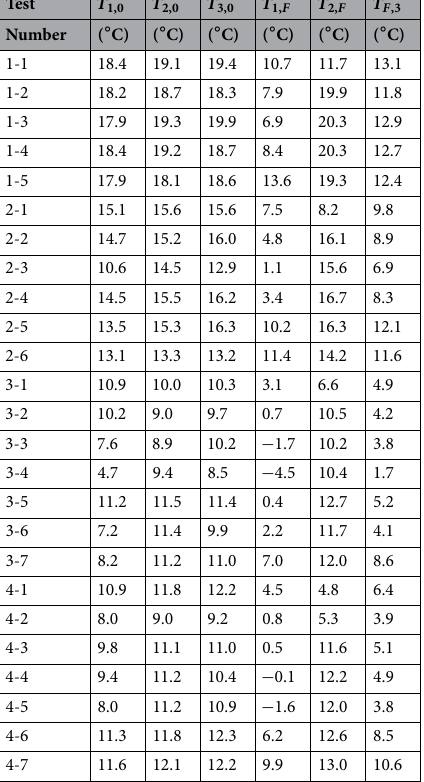
◦ Table 4. The measured temperature ( C) of Cylinder 1 and Cylinder 2 , as well as the manifold temperature 3 , both before 0 and after F the manifold valve was